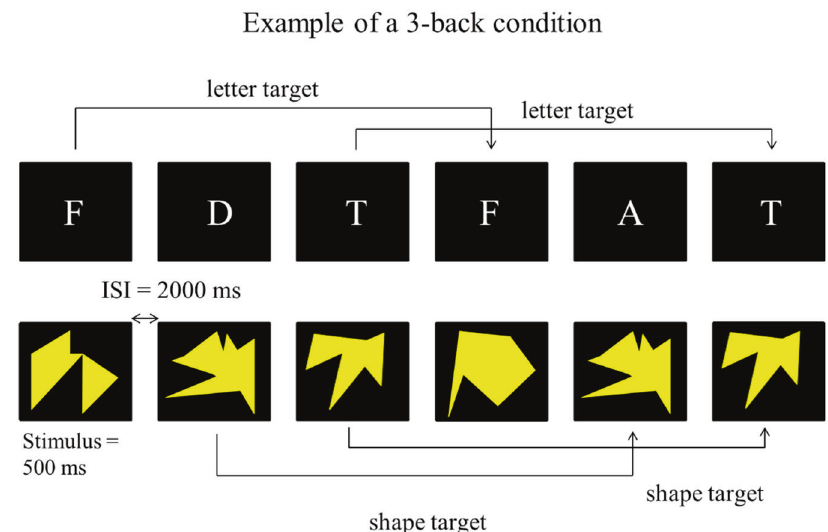
Fig. 2 Example of a verbal 3-back level (top) and a visual 3-back level (bottom). ISI interstimulus